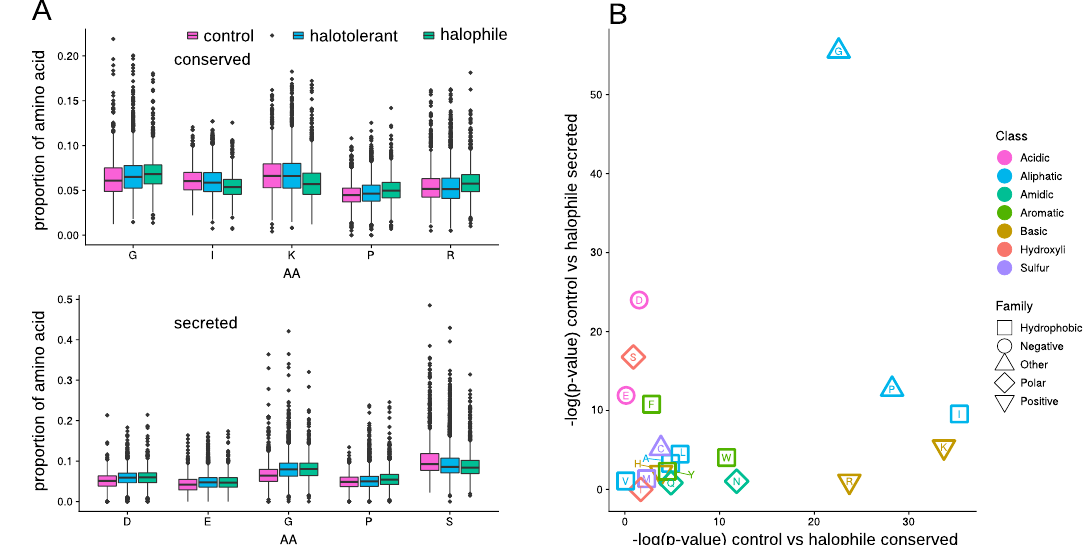
Figure 4. Bias in the amino-acid (AA) distribution between the sets of control, halotolerant, and halophilic fungi. ( A ) Boxplot representing the distribution of AA for the 5 AA with the most significant bias between the control and halophilic group for the set of conserved (top) and secreted proteins (bottom). ( B ) Scatter plot of the − log ( p -value ) computed with the Wilcoxon test for the AA distribution bias for the set of conserved proteins and the set of secreted